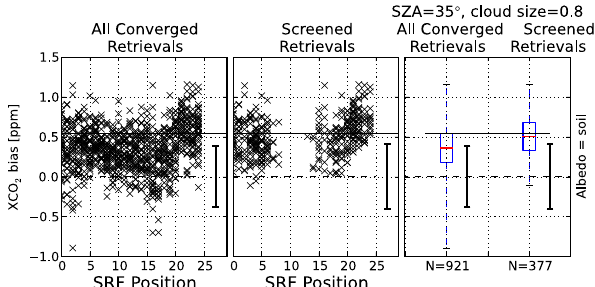
, showing the scatter plot of all Figure 7. Bias in retrieved X CO 2 retrievals (left panel) and screened retrievals (middle panel), com- pared to the single box plot summarizing the bias (right panel). The error bar drawn with a thick black line, centered on zero bias, is the predicted posterior error (1 σ ) from the optimal estimation al- gorithm. The thin horizontal line marks the mean bias for retrievals from a cloud-free simulation. Finally, the number of retrievals in each box plot is indicated at the bottom of the x axis in the right panel.